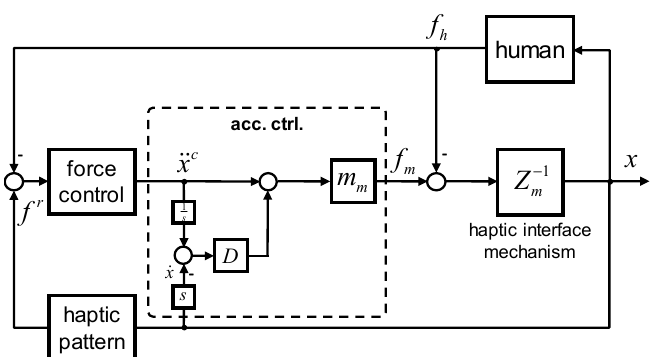
Figure 9. The control block scheme of the haptic interface.